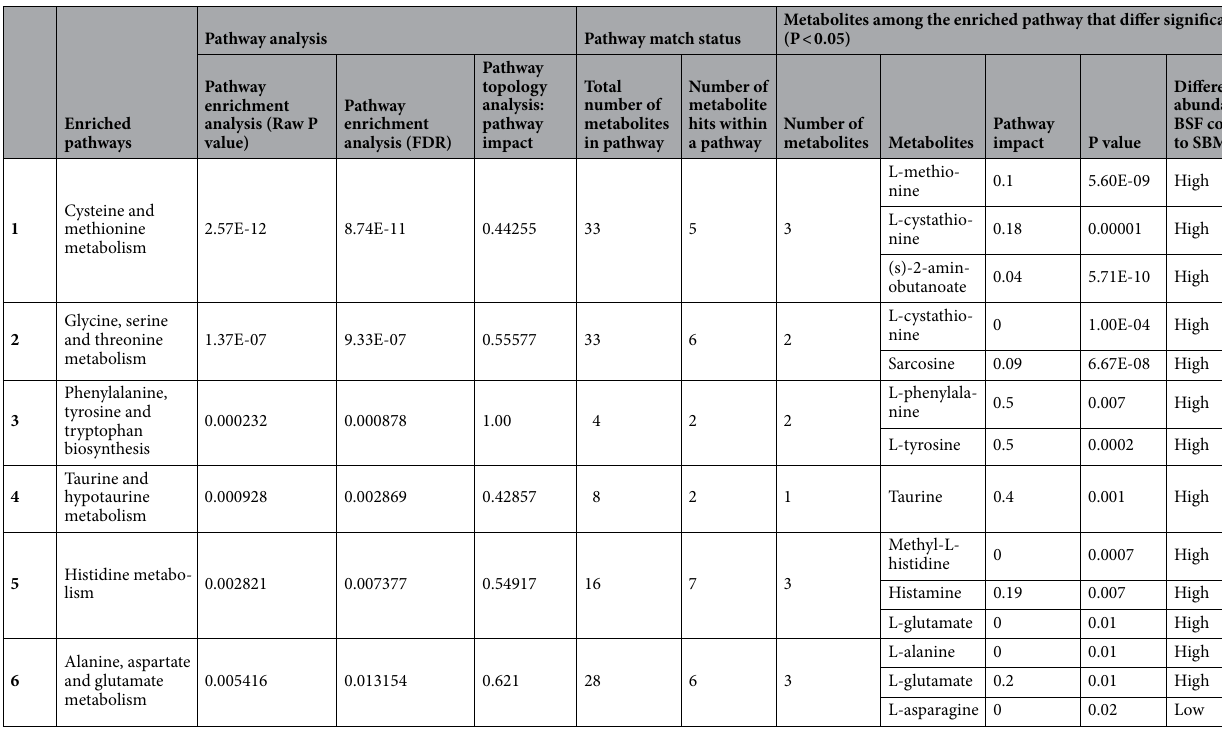
Table 2. Metabolic pathways involving amine metabolites differently expressed in pigs receiving a BSF or SBM based